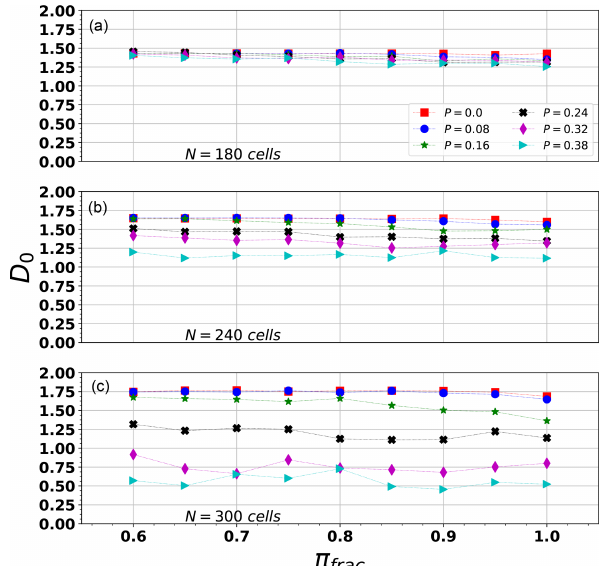
Figure 5. Fractal capacity dimension, D 0 (Sect. 5.1.1) computed for different synthetic series considering three input parameters: the domain size, N ( a – c : N = 180, N = 240, and N = 300 cells per lateral size); the initial load order distribution, P ; and on-fault load- transfer value, π frac